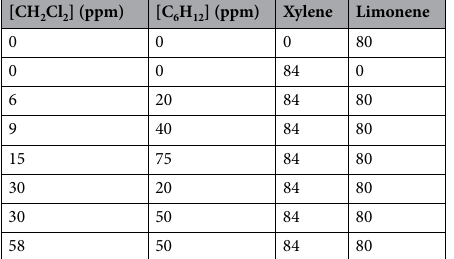
Table 2. Concentration of CH 2 Cl 2 C 6 H 12 , Xylene and Limonene and their mixtures analyzed in the second